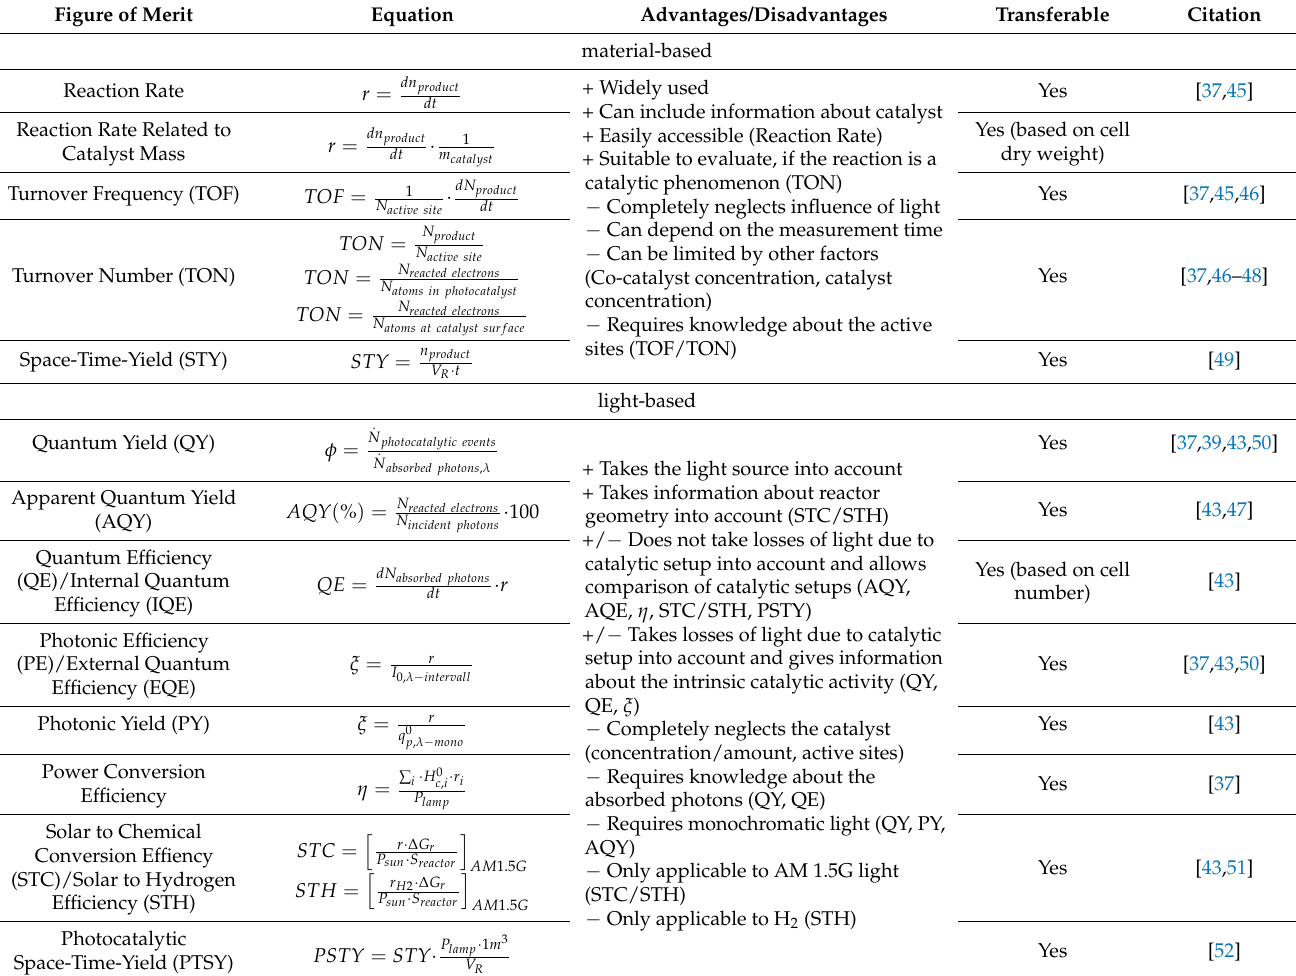
Table 1. Overview of catalytic and photocatalytic figures of merit divided into material based and light based quantities and their transferability towards bio-photocatalytic systems. Figure of Merit Equation Advantages/Disadvantages Transferable Citation material-based Reaction